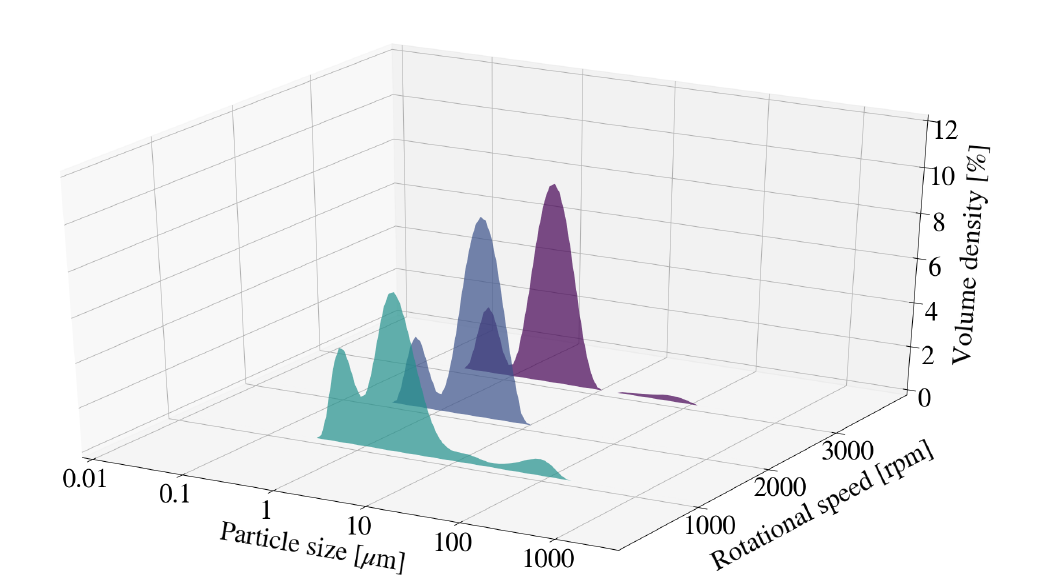
Figure 2. Particle size distribution for Mg-Al LDH samples synthesised at a cooling water inlet temperature of 50 °C, with a change in rotational speed (S13, S14,